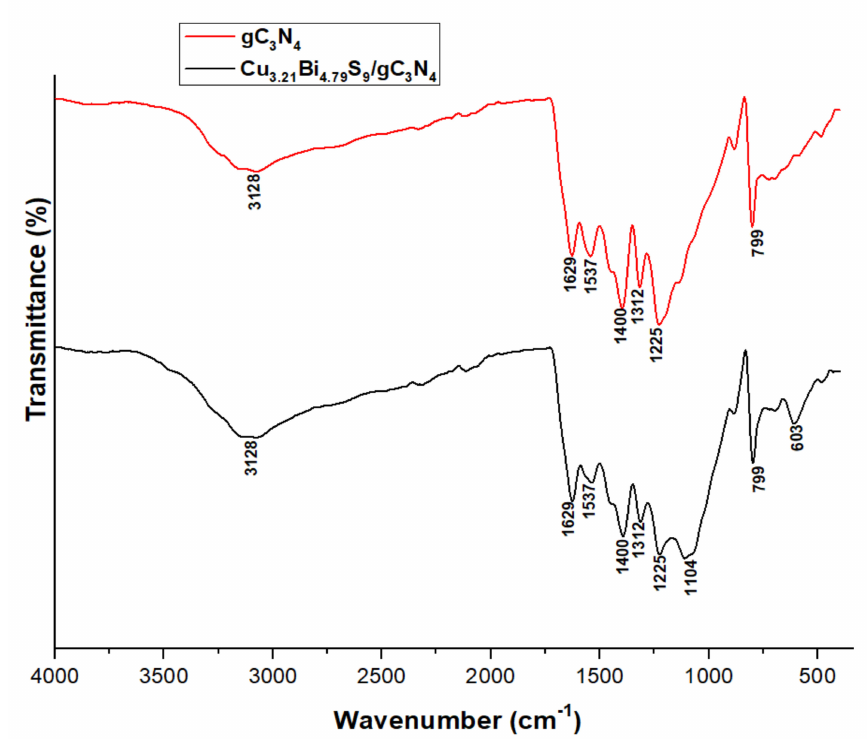
Figure 2. FTIR spectra of gC 3 N 4 and Cu 3.21 Bi 4.79 S 9 /gC 3 N 4 nanocomposite. 2.3. Morphological Properties of Cu 3.21 Bi 4.79 S 9 and Cu 3.21 Bi 4.79 S 9 /gC 3 N